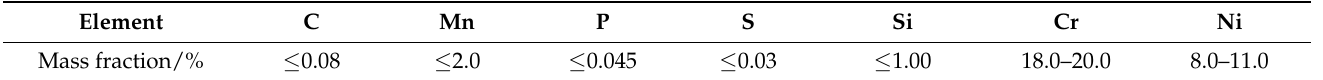
Figure 1. Sample appearance and coating thickness. Table 1. Chemical composition and content of 304 stainless